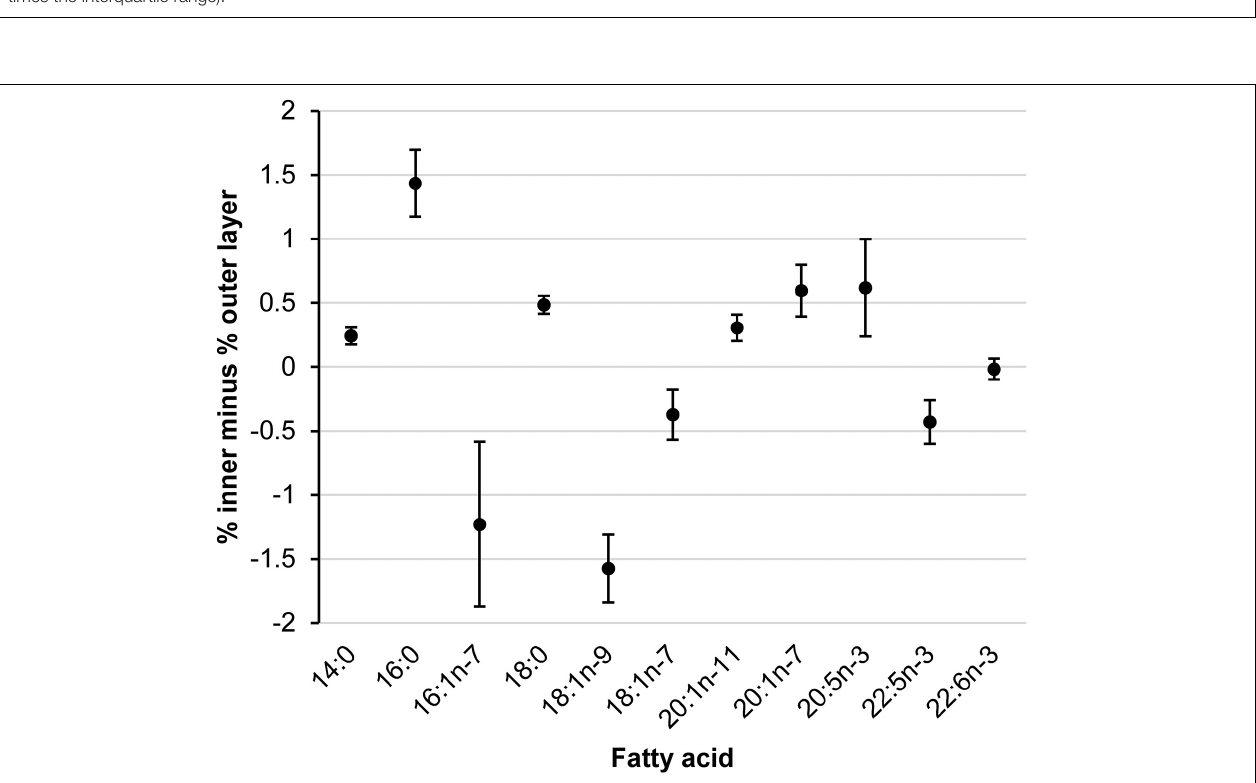
FIGURE 4 | Estimated mean ( ± 2SE) difference in percent abundance of major fatty acids between inner and outer blubber layers averaged across three body sites within 15 lactating Pacific walruses in spring 2007.